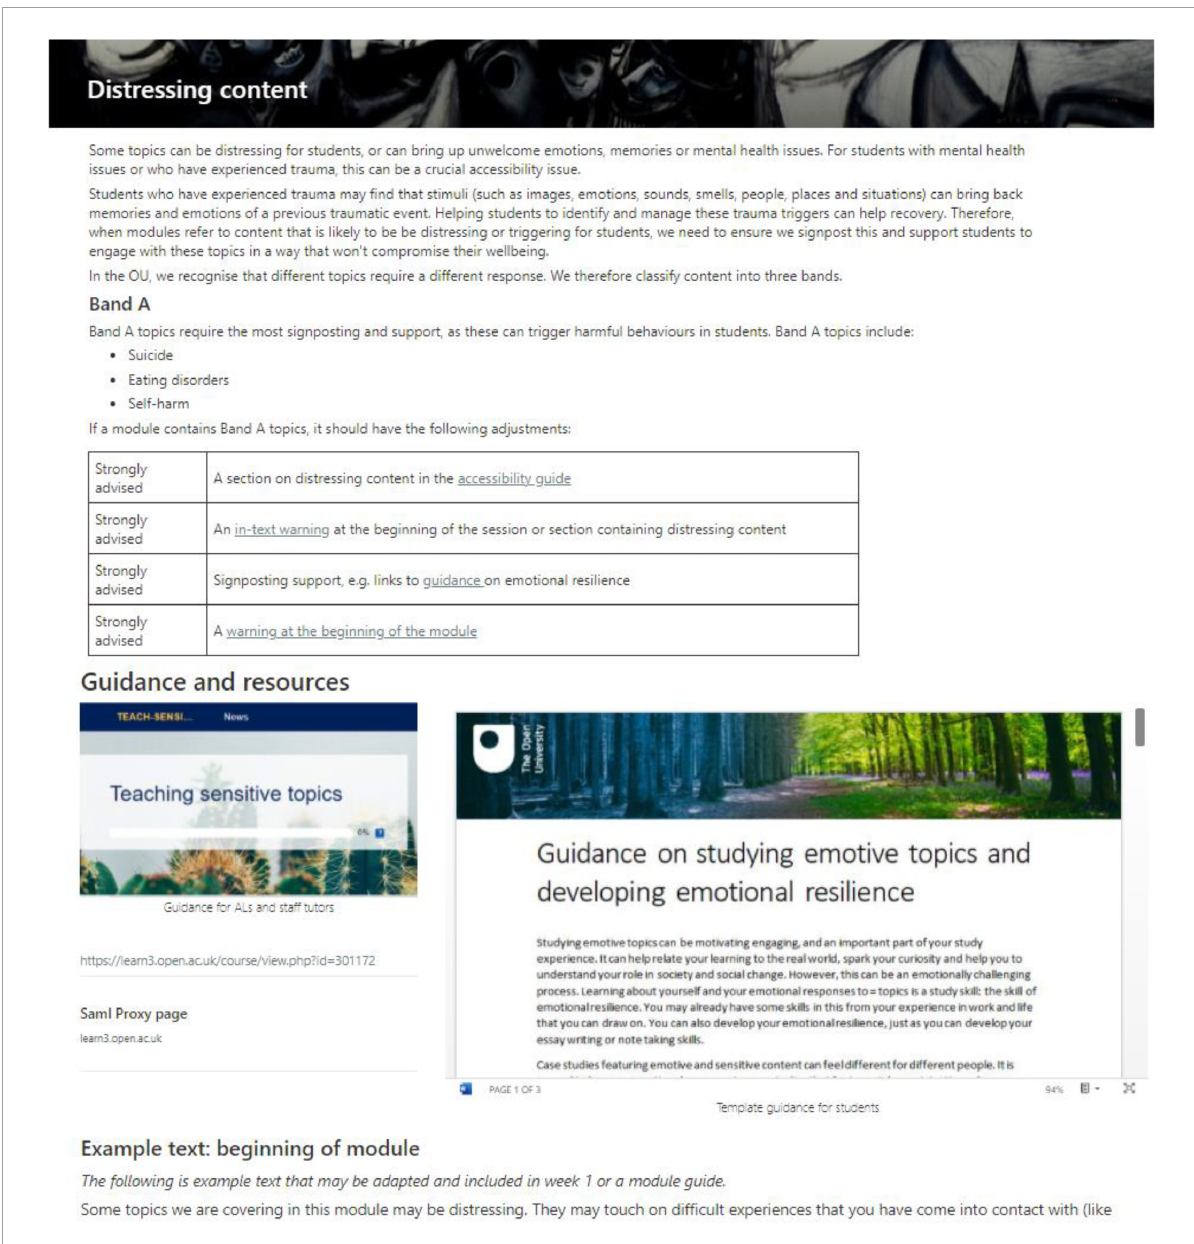
FIGURE5 Open University staff website on distressing curriculum